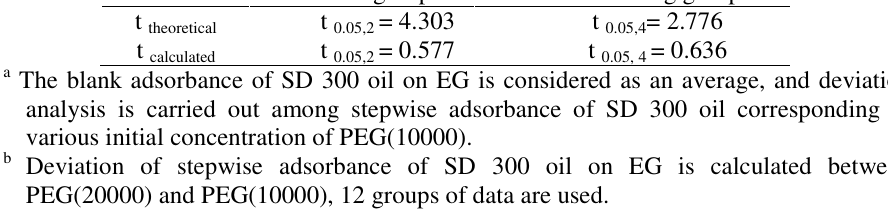
Table 3. t -Test of stepwise adsorption adsorbance of SD 300 oil on EG t -test in group a t -test among groups b